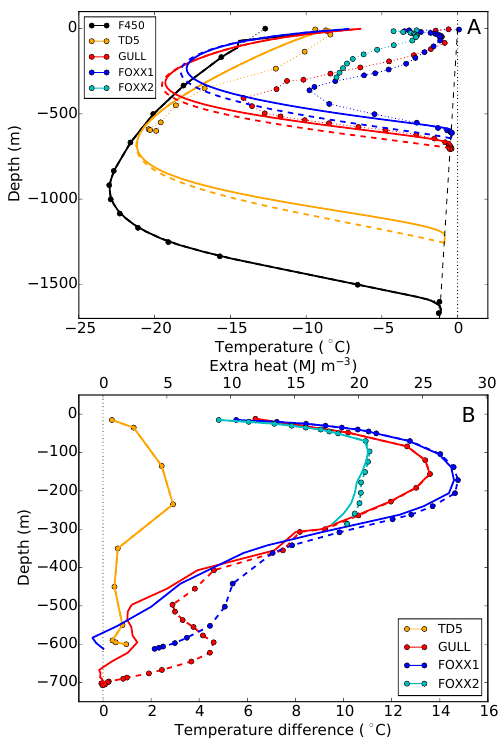
Figure 6. Same as Fig. 5 but for model run mEF (enhanced shear straining and temperate